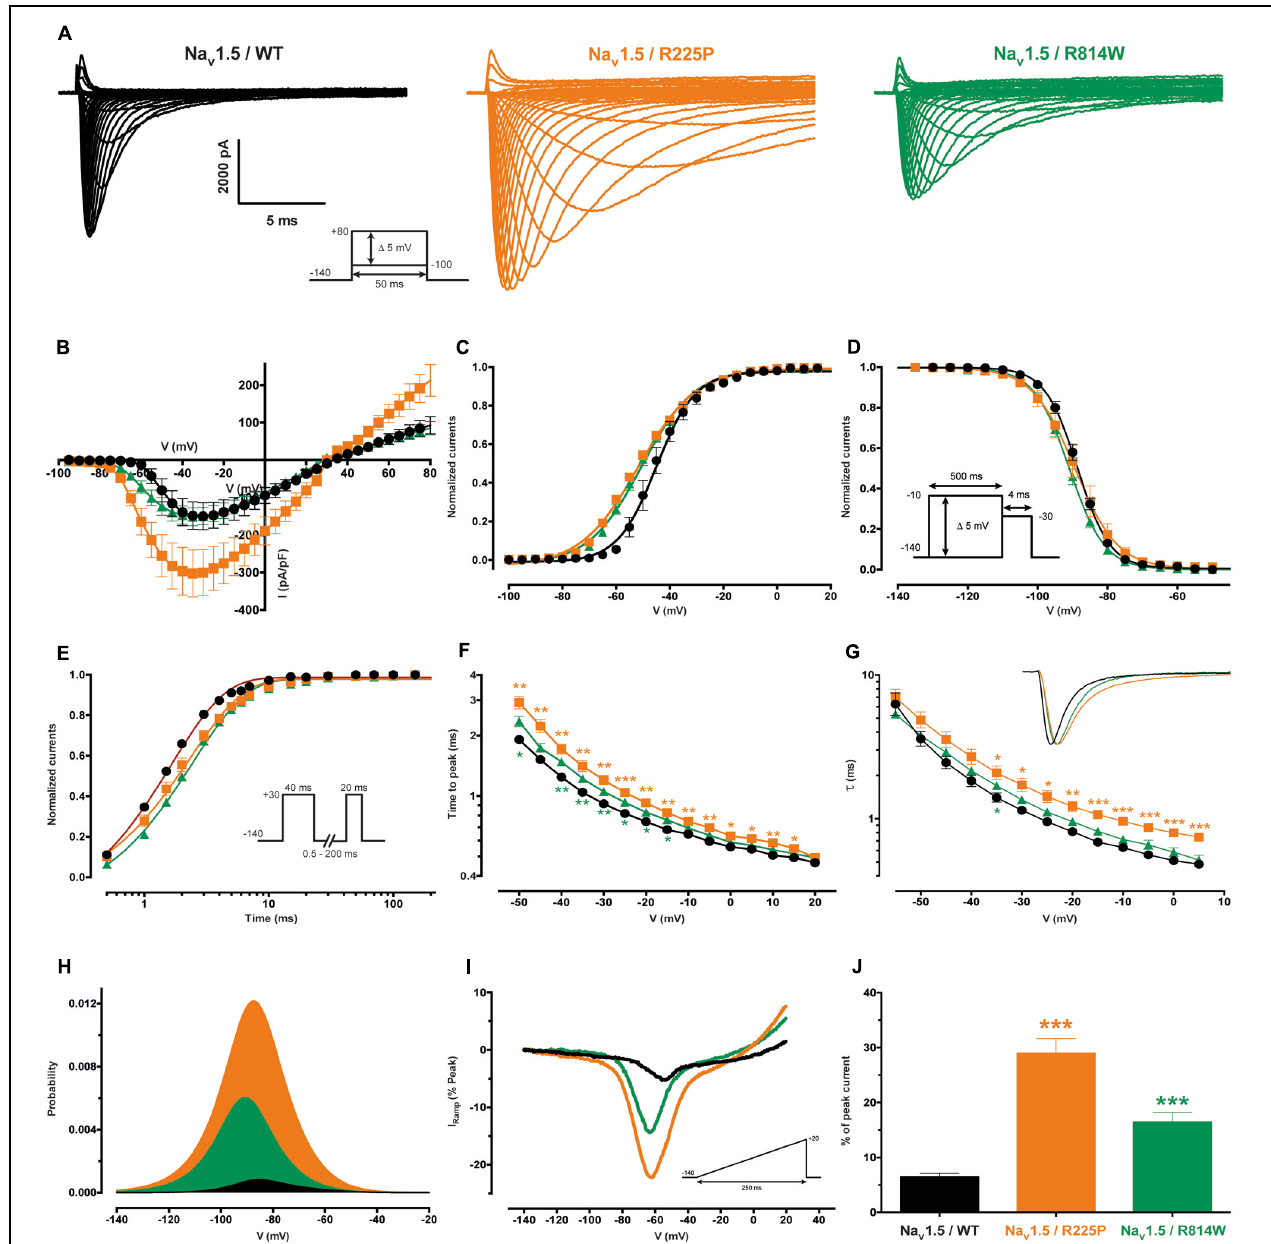
FIGURE 2 | Biophysical characterization of the Na v 1.5 mutant channels. The values for the Na v 1.5 WT channel are indicated by black symbols, those for the R225P mutant channel by orange symbols, and those for the R814W mutant channel by green symbols. (A) Representative whole-cell current traces of the WT and mutant channels (see protocol in inset). (B) Current density-voltage (I–V) relationships of the WT and mutant channels. (C) Voltage-dependence of steady-state activation of the WT and mutant channels. Activation curves were generated using a standard Boltzmann distribution [ G ( V )/ G max = 1/(1 + exp(-( V − V 1 / 2 )/ k ))] and gave the V 1 / 2 and k values listed in Table 1 . (D) Steady state inactivation of the WT and mutant channels (see protocol in inset). The recorded inactivation values were fitted to a standard Boltzmann equation [ I ( V )/ I max = 1/(1 + exp(( V − V 1 / 2 )/ k )) + C] and gave the values listed in Table 1 . (E) Recovery from fast inactivation values were obtained using a two-pulse protocol at + 30 mV to obtain maximal activation (see protocol in inset). The time constants listed in Table 1 were obtained using a single-exponential function: (A fast x (1 – exp(-t/ τ fast )) + C). (F) The times to peak of the WT and mutant channels were used to evaluate activation kinetics. The times to peak were measured from the same current traces used to construct the I-V relationship (A) . (G) The time constants of fast inactivation decay were plotted as a function of voltage for the WT and mutant channels. The time constants were obtained using a simple-exponential function: (A x (exp(-t/ τ ) + C). Normalized raw data shown in the inset illustrate the current decay kinetics. (H) The overlap between activation and inactivation defines the window current. The predicted window current was obtained using the following equation: (1/(1 + exp((V 1 / 2activation – V)/k activation )) x ((1 – C)/(1 + exp((V – V 1 / 2inactivation )/k inactivation )) + C). (I) Ramp protocols (see protocol in inset) were imposed (0.64 mV/ms) to study the window current. Ramp current traces were normalized to the alpha peak current. (J) Histogram showing the peak window current normalized to the alpha peak current (% of peak current). ∗ Difference vs. Na v 1.5/WT using ANOVA ( ∗∗∗ P < 0.001).